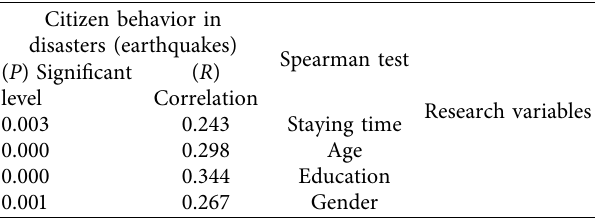
Table 5: Correlation coefficient results in research variables. Citizen behavior in